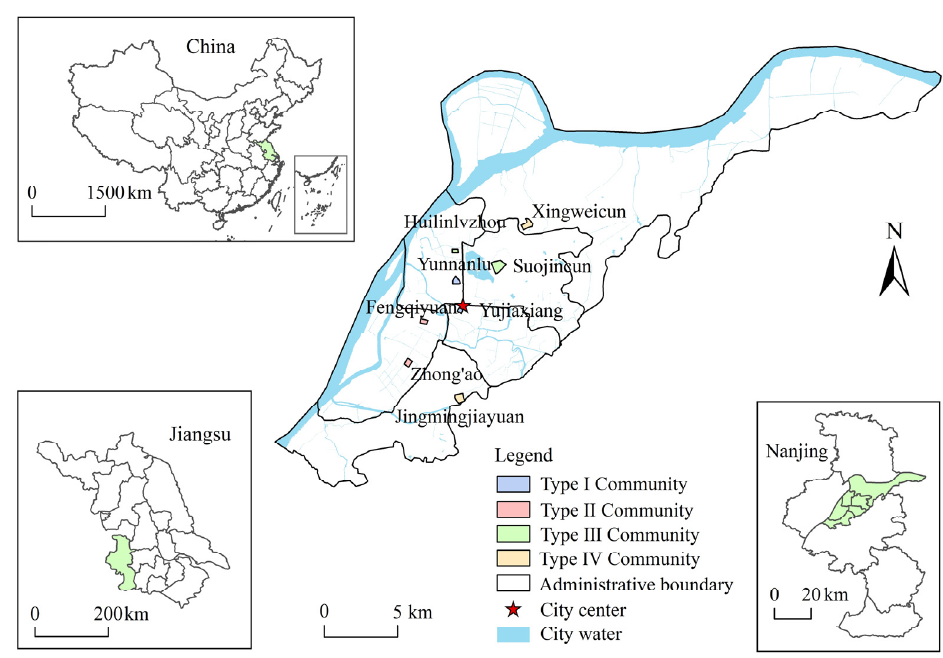
Figure 1. Spatial distribution of the communities surveyed in the study area of Nanjing.